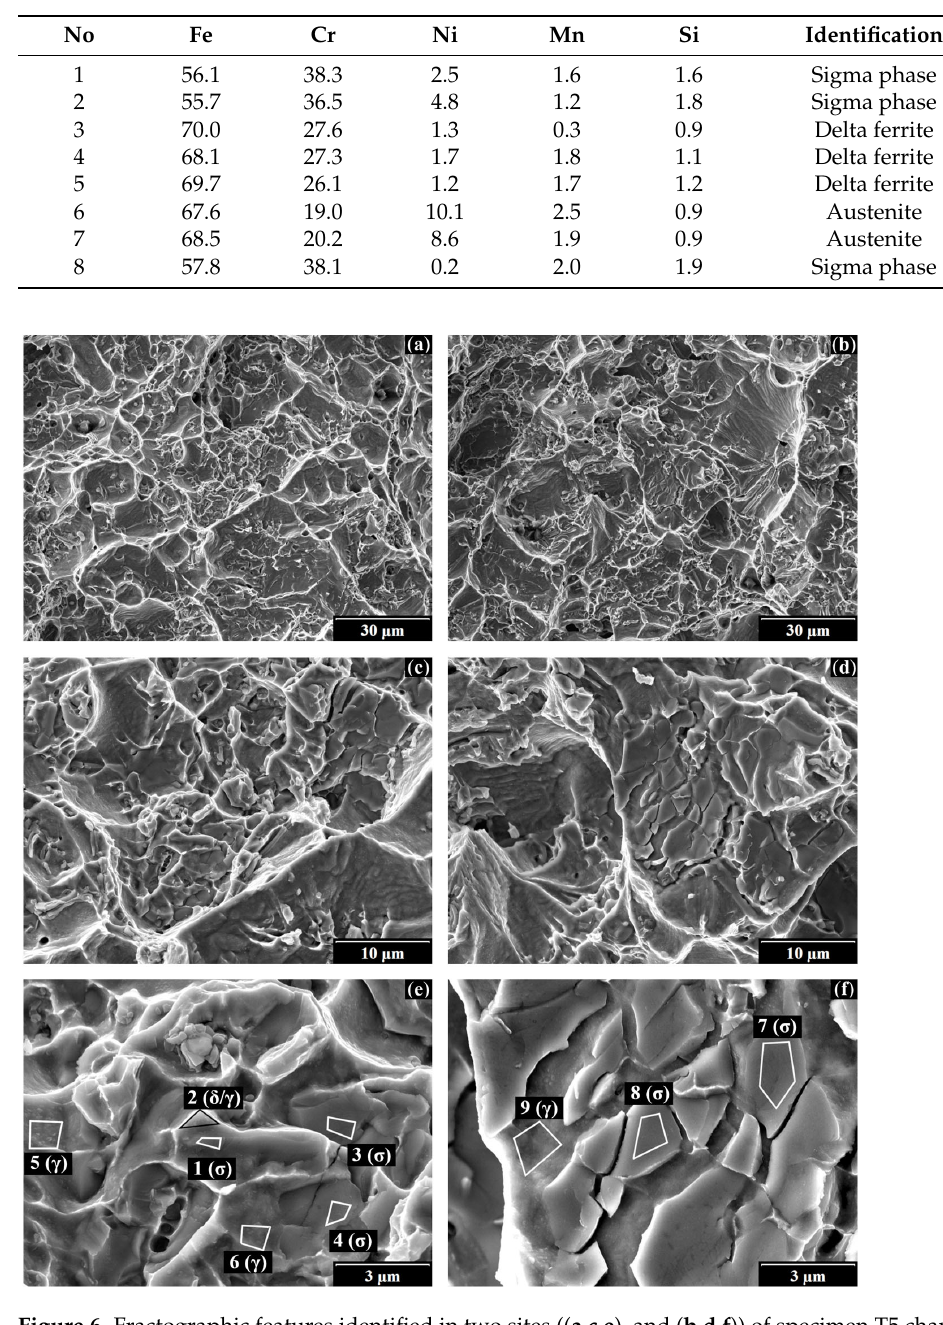
Table 3. Results of EDX analysis performed in sites 1–8 depicted in Figure 4b: Amounts of relevant elements in wt.%, and identification of phases.